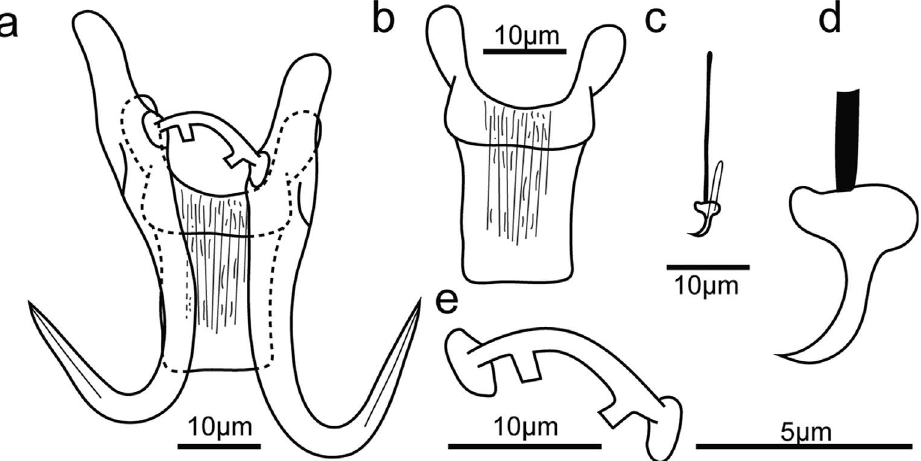
Figure 10. Opisthaptoral sclerotized parts of Gyrodactylus sp1. (a) Central hook complex; (b) ventral bar; (c) hook; (d) hook sickle; (e) dorsal